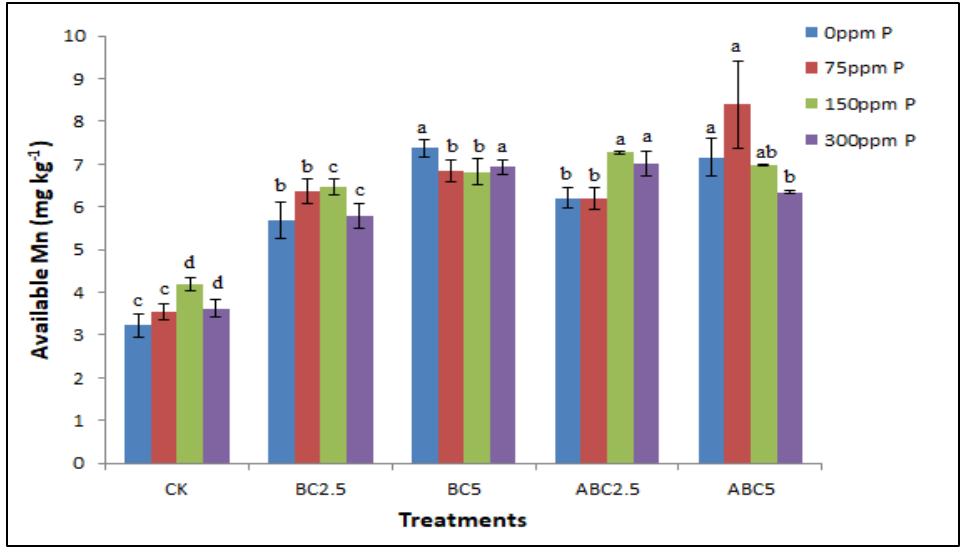
Figure 7. Effects of BC and ABC applied at different rates with different P fertilizer application rates on soil available Mn (mg kg − 1 ). Means with different letters within each fertilizer rate across each treatment indicate significant differences according to the least significant difference (LSD) test at p < 0.05. CK = Control, BC2.5 = Biochar added at 2.5% w / w , BC5 = Biochar added at 5% w / w , ABC2.5 = Acidified biochar added at 2.5% w / w , and ABC5 = Acidified biochar added at 5% w / w .